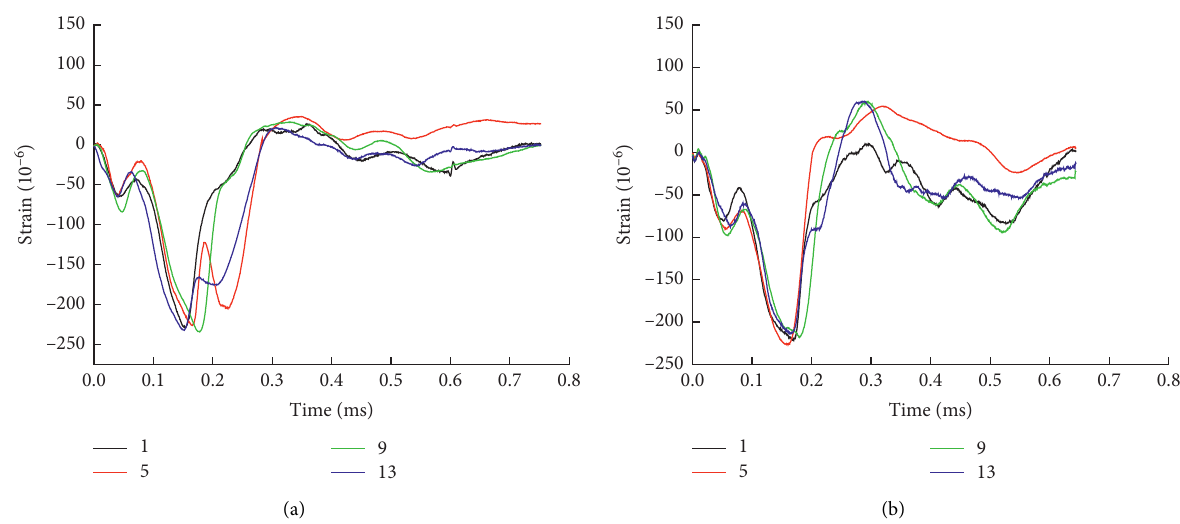
Figure 16: Time-history curves of measuring points near explosion source without confining pressure. (a) T1 sample. (b) T2 sample.